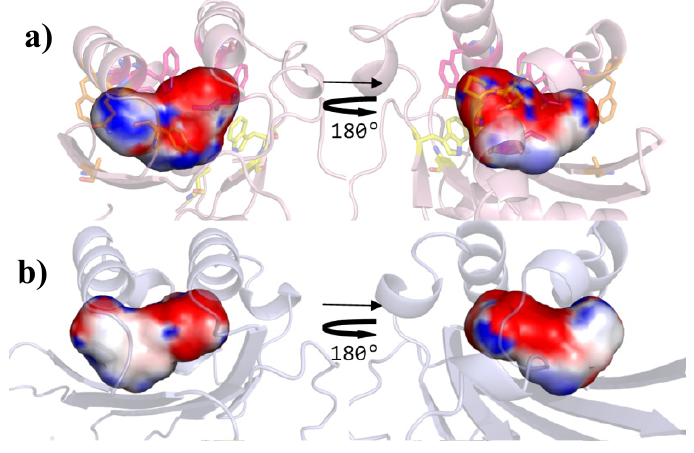
Figure 6. Electrostatic potential of the ligand-binding sites of the QS LuxR and of the prototype of the PAB LuxR solos subfamily. ( a ) TraR (PDB_ID 1H0M [24]) in light pink (showing the side chains of the conserved core in yellow, of the specificity patch in magenta and of the variable patch in orange); ( b ) SdiA (PDB_ID 2AVX [30]) in light blue; ( c ) LasR (PDB_ID 3IX3) in light orange; ( d ) CviR (PDB_ID 3QP1 [29]) in light green; ( e ) QscR (PDB_ID 3SZT [28]) in light yellow; ( f ) OryR model in blue purple. Left column: top view of the ligand binding sites (same orientation of the previous Figures); Right column: bottom view (obtained by 180 degrees rotation around y